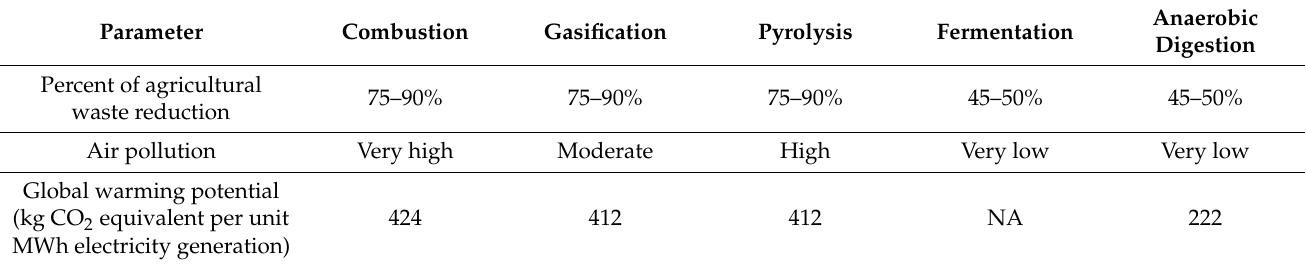
Table 4. Comparison of the conversion technologies on the percentage reduction of agricultural waste, air pollution, and global warming potential